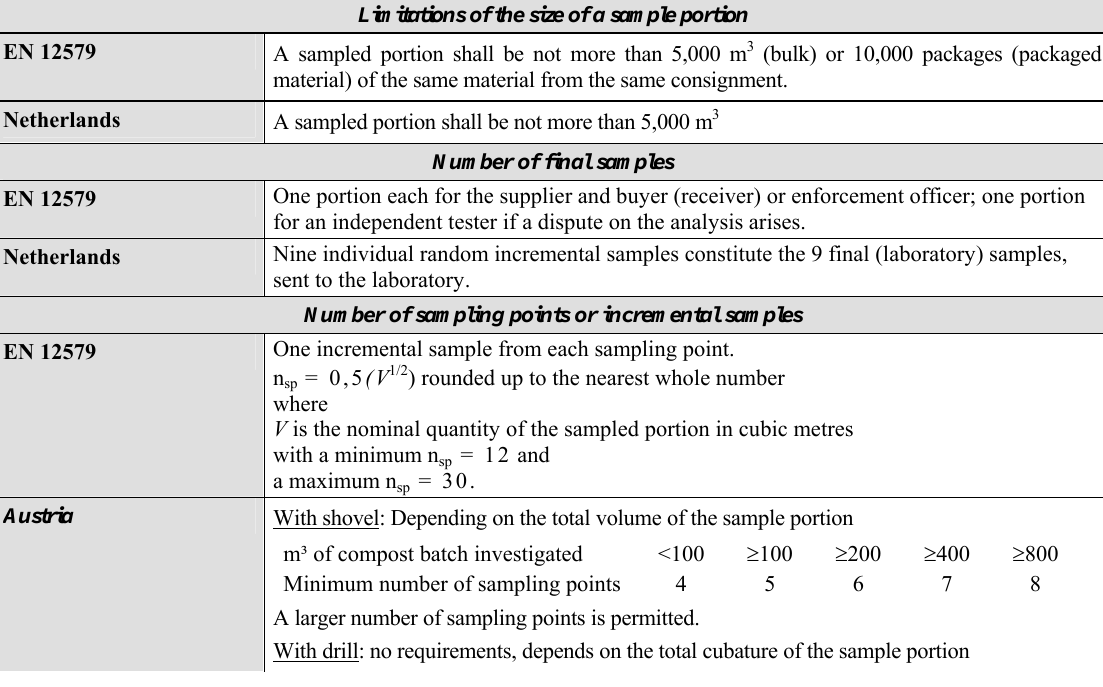
Table 11: Schemes for sample taking for